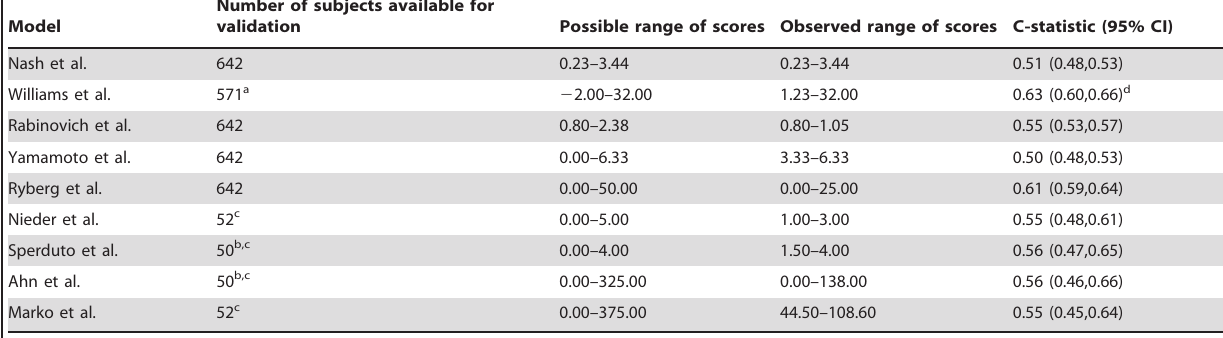
Table 4. Validation of selected models for prediction of survival of patients with de novo metastatic breast cancer.